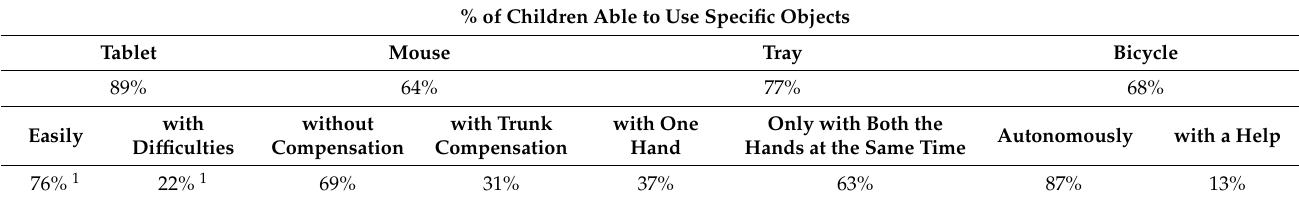
Table 1. Percentage of children with neurological impairments able to use a tablet, mouse, tray, and bicycle. The percentage of those who find these objects easy or difficult to use is also